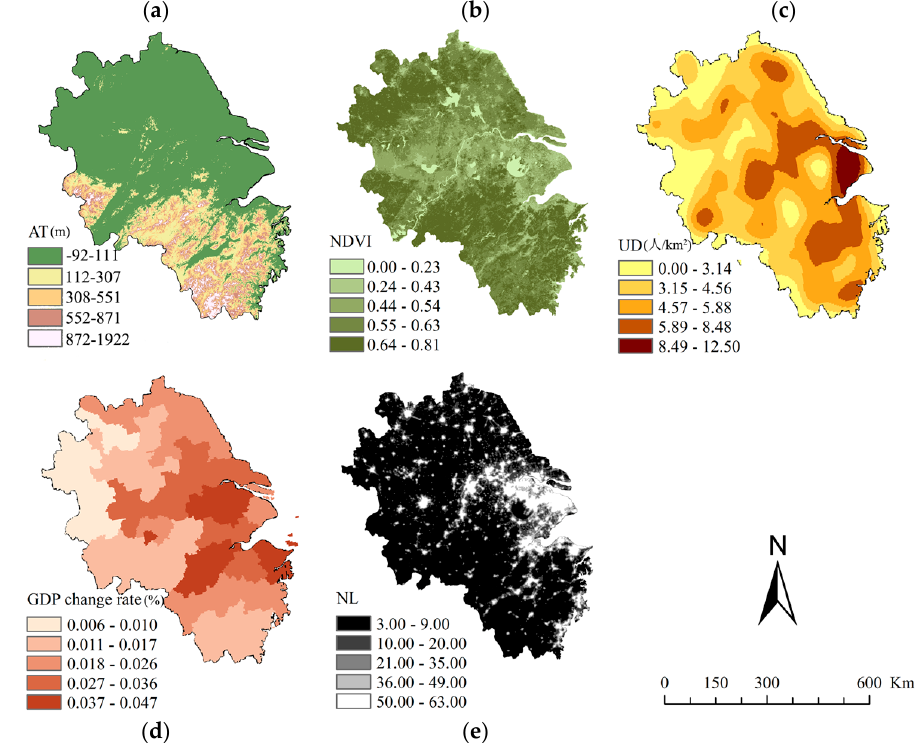
Figure 2. The distribution of driving factors: ( a ) altitude (AT); ( b ) normalized difference vegetation index (NDVI); ( c ) urban density (UD); ( d ) gross domestic product (GDP) change rate; ( e ) night light (NL).